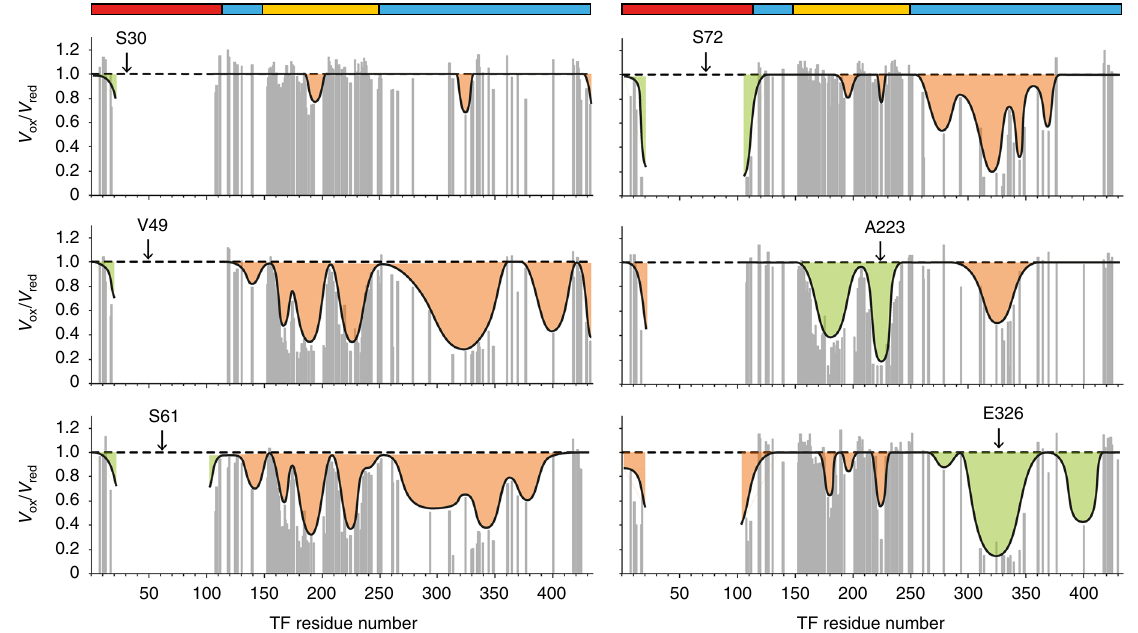
Fig. 4 Domain contacts in the full-length TF dimer. Result of PRE experiments with a paramagnetic spin label attached to one of the positions S30, V49, S61, S72, A223, and E326 in full-length TF measured in sample buffer (20mM K-phosphate pH 6.5, 100mM KCl, 0.5mM EDTA) at 25°C and 700MHz. The peak volume ratio between oxidized and reduced samples from 2D [ 15 N, 1 H]-TROSY is plotted against the residue number. For visualization purposes, a value of 0.15 is shown for the peaks that were broadened beyond detection in the paramagnetic sample. Data are shown only for non-overlapping resonances. The black line outlines the PRE effect observed for each mutant. The orange-shaded regions correspond to intermolecular PRE and the green shaded to intramolecular effects, as expected from the monomeric crystal structure (PDB 1W26). The colored bars on top show the sequence domain organization as in Fig.